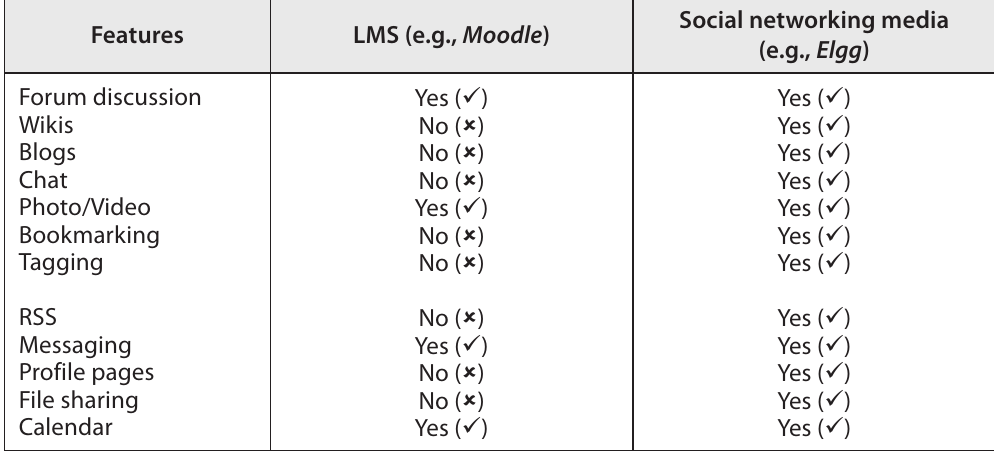
Table 2 Comparison between an LMS and social networking